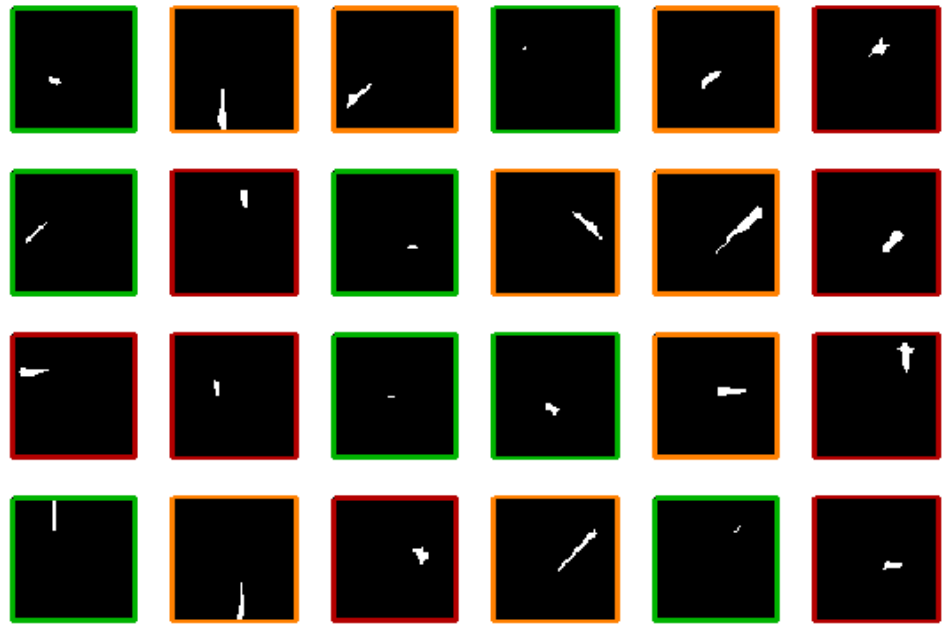
Figure 7. Samples taken from the available dataset. The box colour is representative of the defect type: in green, the healthy indications; in orange, the linear ones; and in red, the